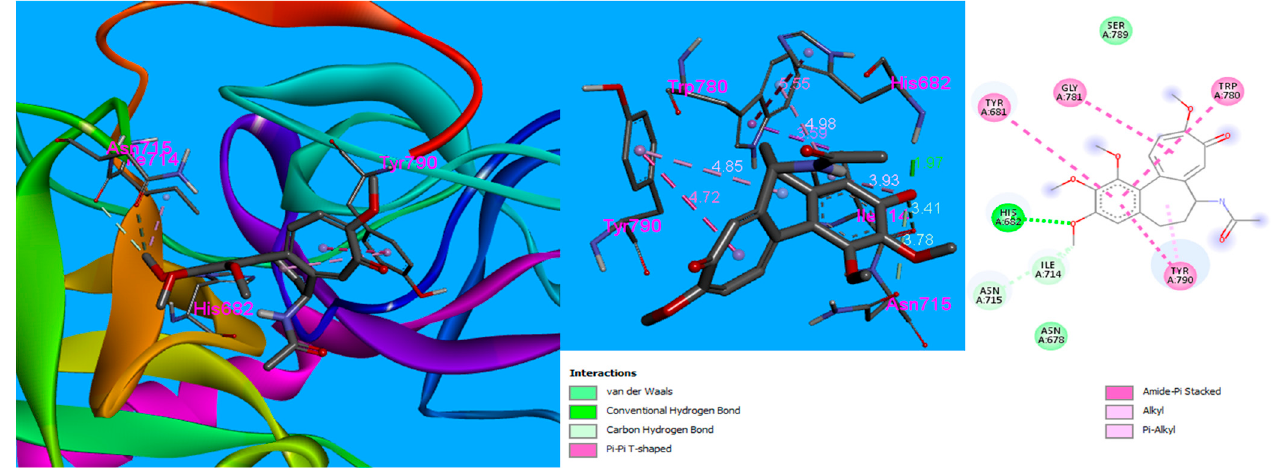
Figure 11. Molecular docking interaction of 1 on protease enzyme.